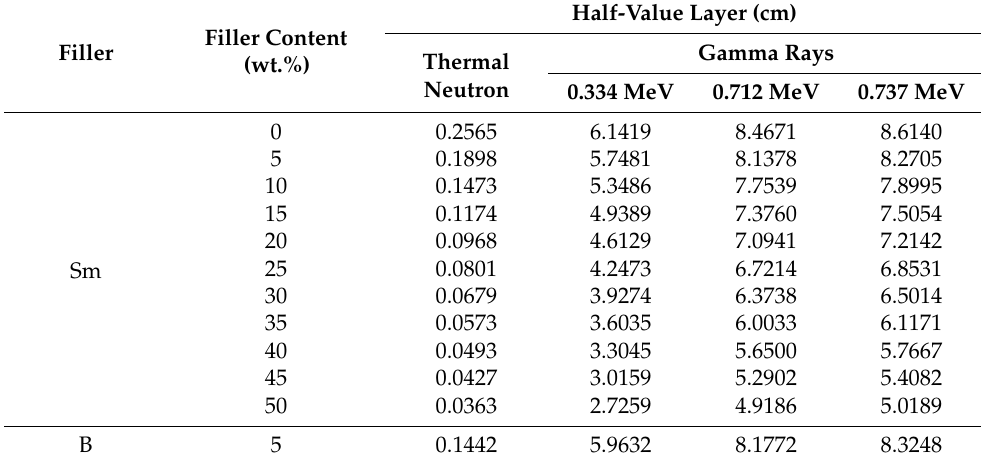
Table 5. Half-value layer (HVL) for neutron and self-emitted gamma attenuation of Sm 2 O 3 /UHMWPE composites and a commercial 5% borated PE, determined by using PHITS. Filler Content Filler (wt.%)